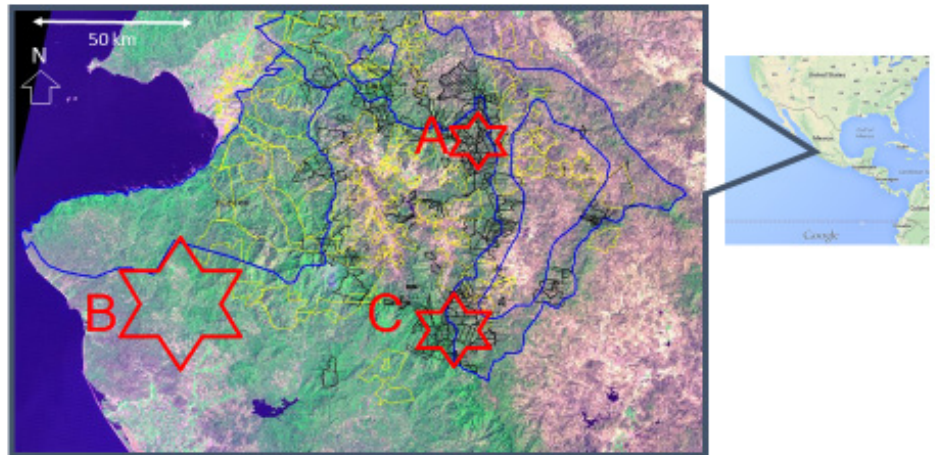
Figure 1. Study cases location. Corrales ( A ); Santa Cruz del Tuito ( B ); El Llanito y cuatro más ( C ), Jalisco, México. Yellow and black lines are timberland property boundaries, blue line is the limit of the natural protected